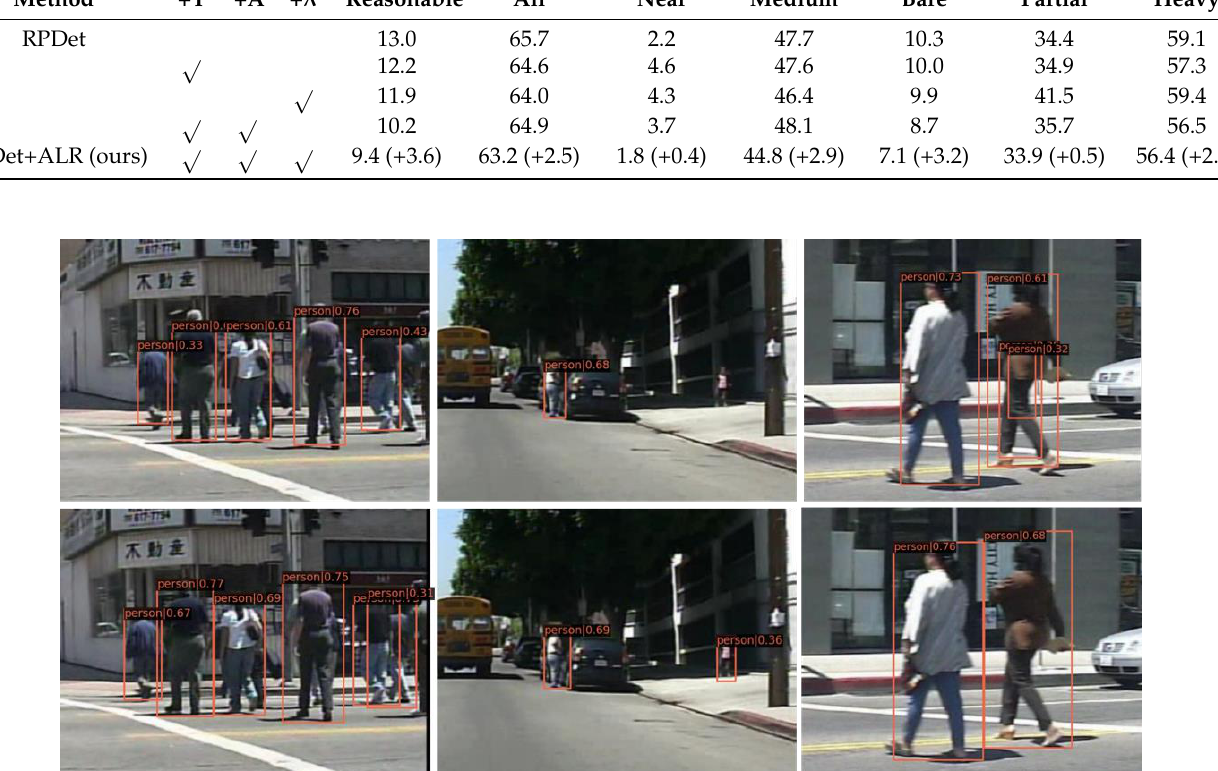
Figure 5. Qualitative results from the baseline method ( the first row ) and our RPDet+ALR ( the second row ) in the Caltech-USA testing set.